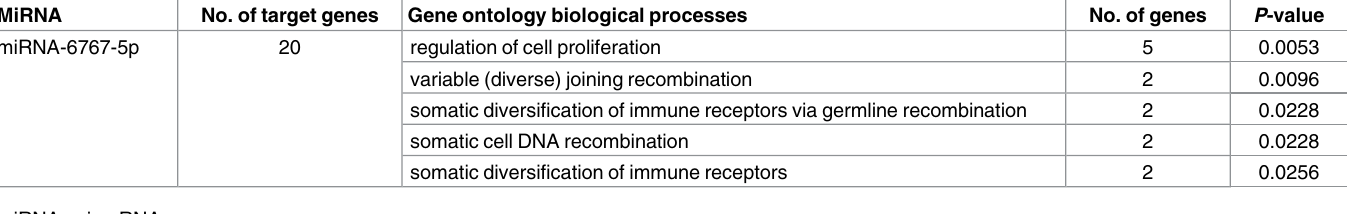
Table 5. Gene ontology biological process annotations associated with target genes of differentially expressedmiRNAs in women with polycys- tic ovary syndrome.